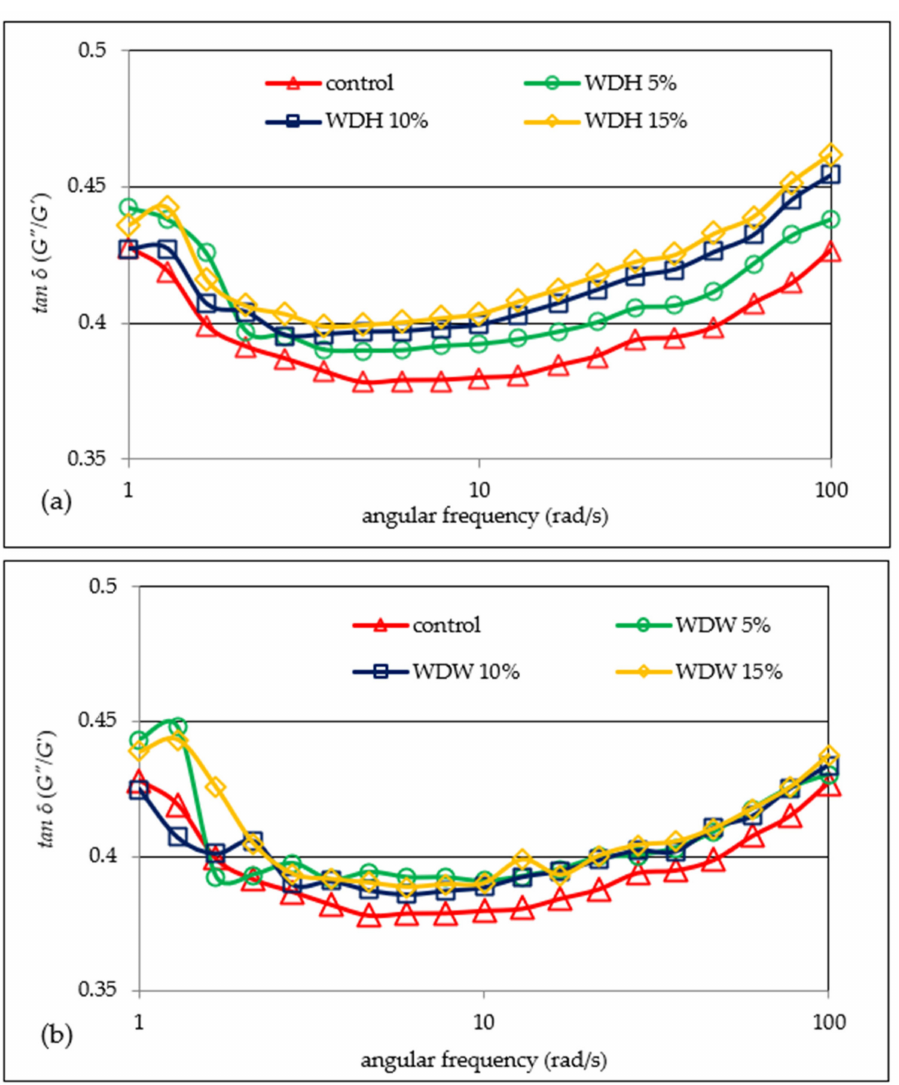
Figure 3. Tangent δ ’s dependence on the angular frequency of the analyzed doughs with the addition of hazelnut ( a ) or walnut ( b )